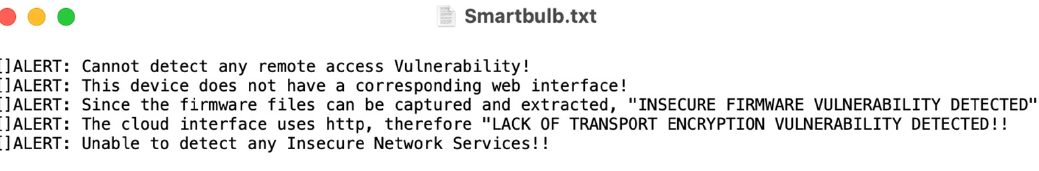
Figure 6. Security testing results for the Tp-link Smart bulb.